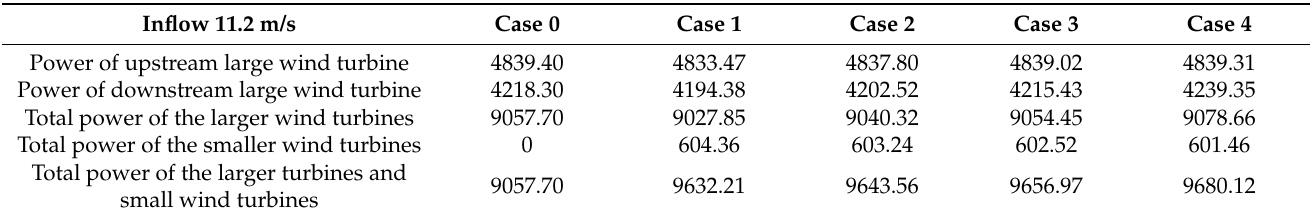
Table 5. Comparison of the power of downstream large wind turbines under different number simulation cases (unit: kW).